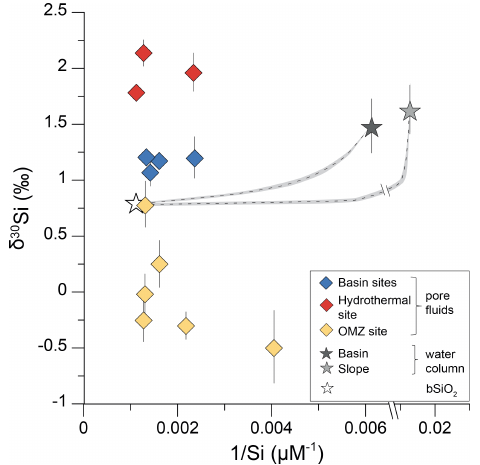
Figure 3. Pore fluid δ 30 Si values are displayed versus the inverse Si concentration (1 / Si) for the basin sites, the hydrothermal site, and the OMZ site. Error bars not indicated are within symbol size. Mix- ing curves are calculated following Eq. (3) between the respective water column and the average bSiO 2 δ 30 Si value for all sites (see text for details). The grey-shaded area indicates the uncertainty on the equilibrium solubility of bSiO 2 assuming 900 ± 150µM follow- ing Van Cappellen and Qiu